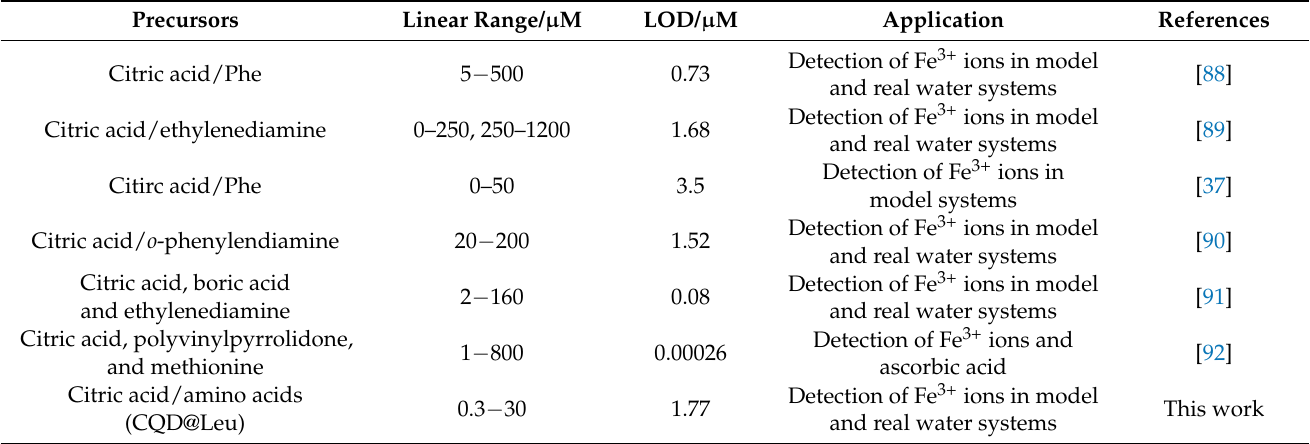
Table 5. Summary of recent published works reporting the application of CQDs prepared from citric acid in Fe 3+